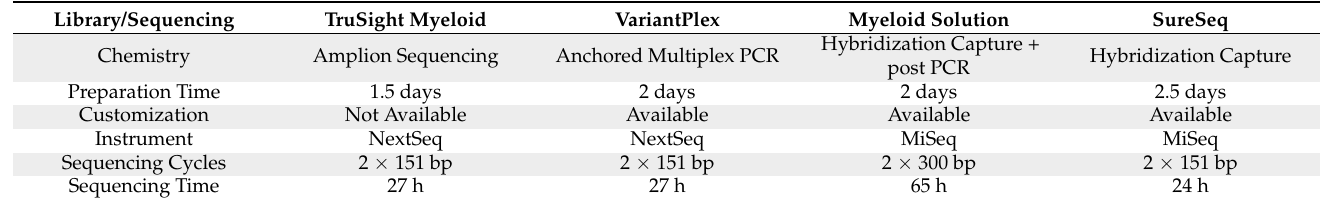
Table 2. Workflow